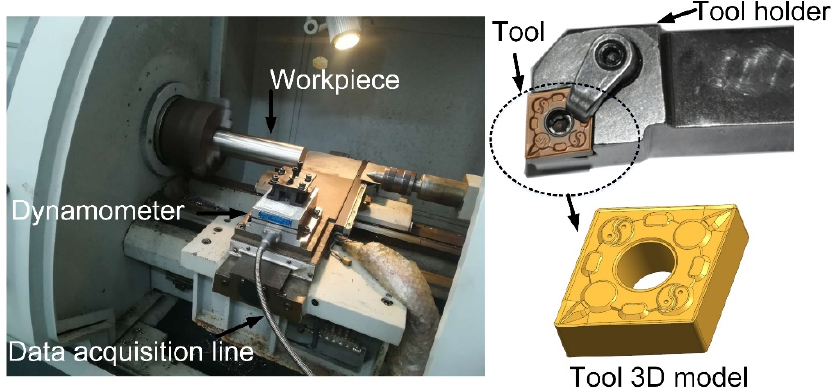
Figure 2. Turning test device and tool 3D model. Table 2. Physical properties of tool and workpiece.